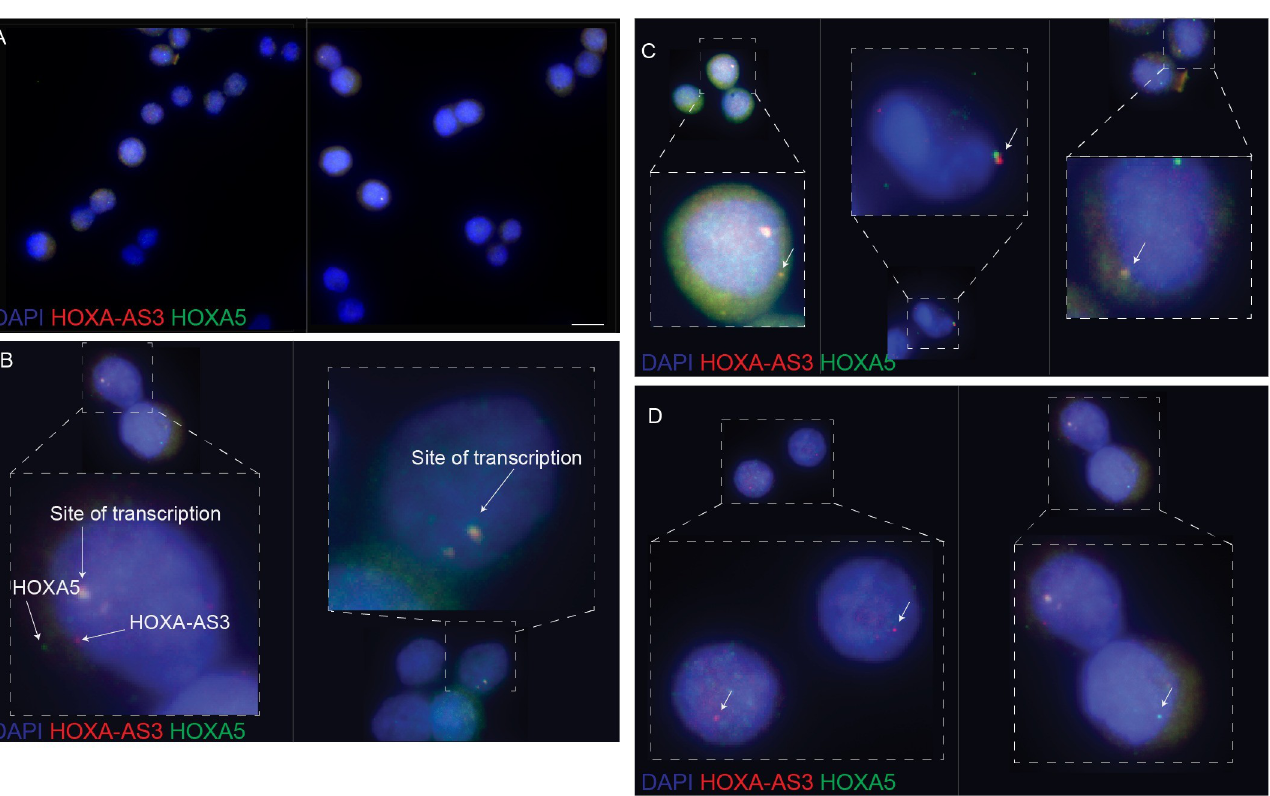
Fig 5. Single-molecule FISH detection of HOXA-AS3 and HOXA5 in HT-29 cells. (A) HOXA-AS3 (red) and HOXA5 (green) transcripts in a sample of HT-29 cells. Scale bar: 10 μ m. (B) HOXA-AS3 and HOXA5 are co-localized at their presumed site of transcription. (C) HOXA-AS3 and HOXA5 are occasionally co- localized in the perinuclear area (white arrow). (D) HOXA-AS3 and HOXA5 are occasionally expressed